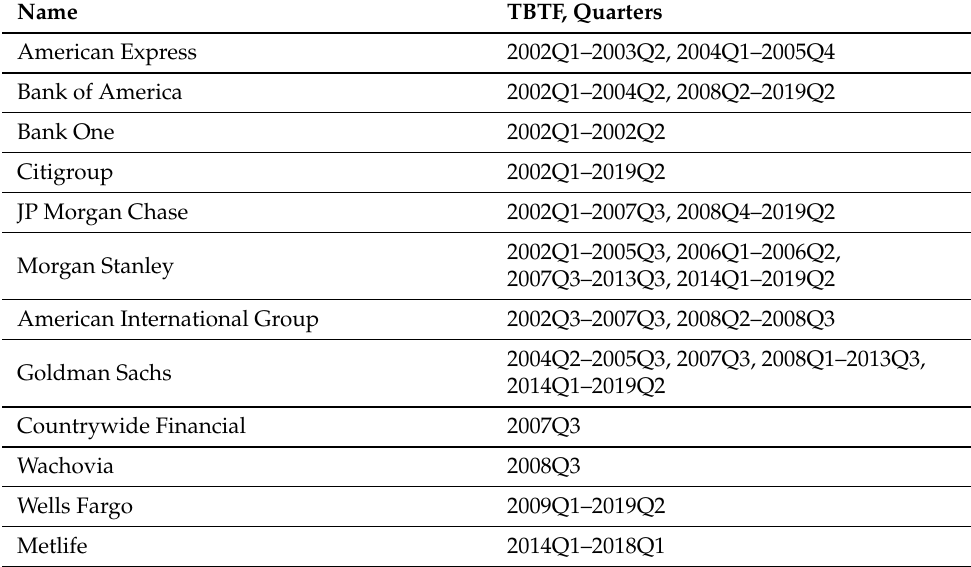
Table 6. List of TBTF Financial Institutions based on Asset Loss Beta. This table reports TBTF financial institutions from 2002Q1 to 2019Q2 from the publicly listed firms with assets over $50 billion by using asset loss portfolio. The asset loss portfolio is estimated based on the total asset from Compustat and total equity from CRSP in the spirit of Adrian and Brunnermeier (2016). This table extends